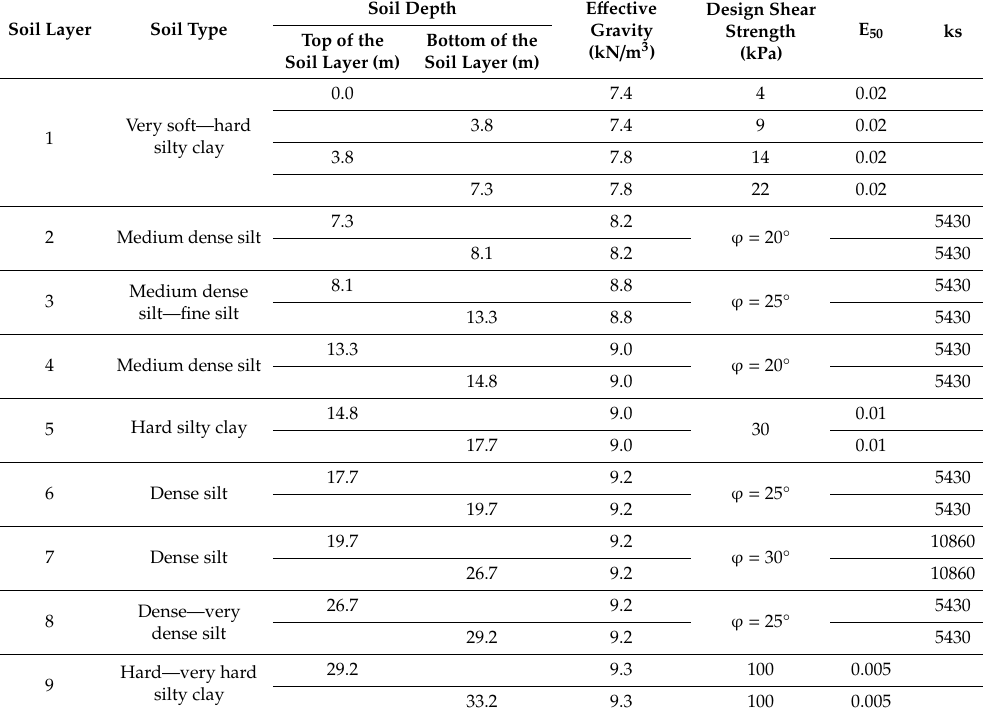
Table 2. Soil material properties used in the FE